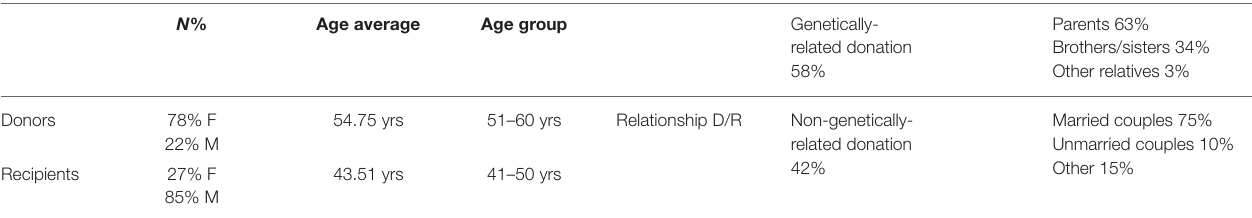
TABLE 1 | Summary of the results from potential donor-recipient pairs’ assessment by the “Third-Party” Commission (Hospital “Città della Salute e della Scienza” of Turin,